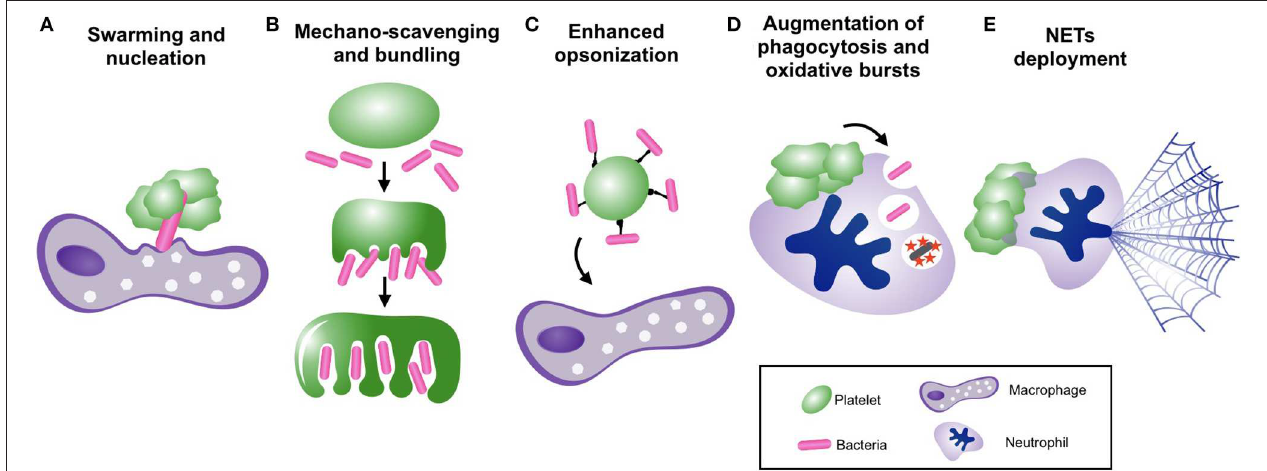
FIGURE 2 | Platelets collaborate with neutrophils and other immune cells to facilitate bacterial clearance from the bloodstream. Mechanisms of bacterial clearance facilitated by platelet-leukocyte interactions, including, (A) vascular surveillance and nucleation of bacterial invaders to promote phagocytosis by macrophages, (B)